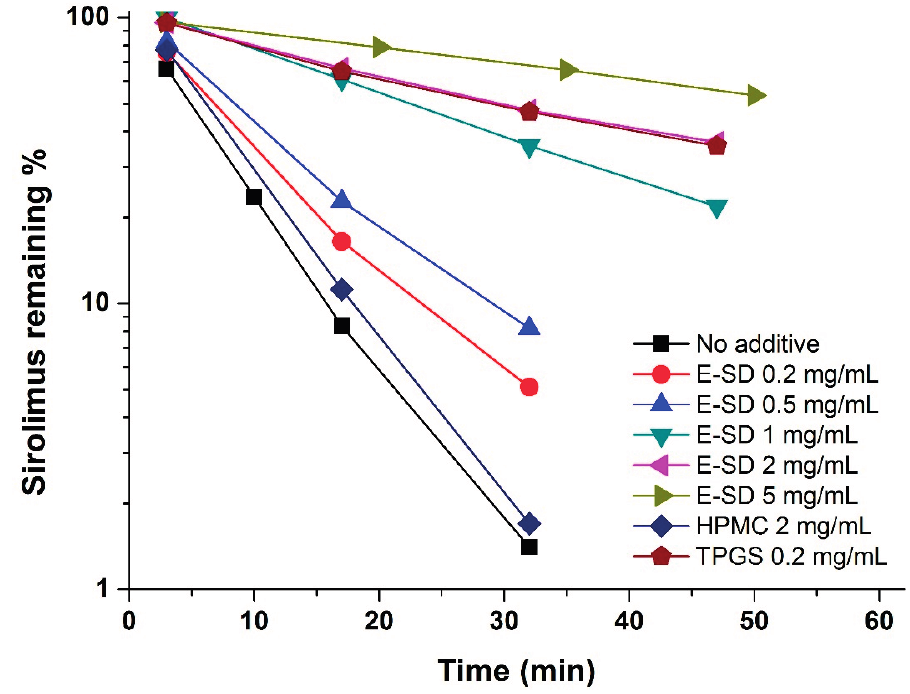
Figure 1. Effect of E-SD on the degradation of sirolimus in simulated gastric fluid (pH